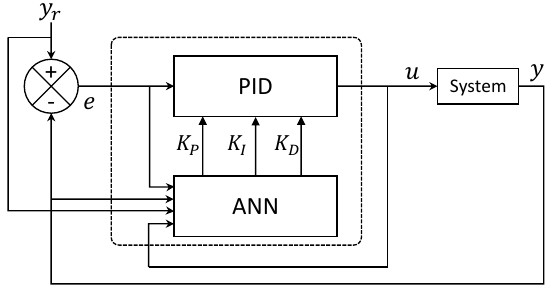
Figure 3. Hybrid PID controller scheme. ANN: Artificial Neural